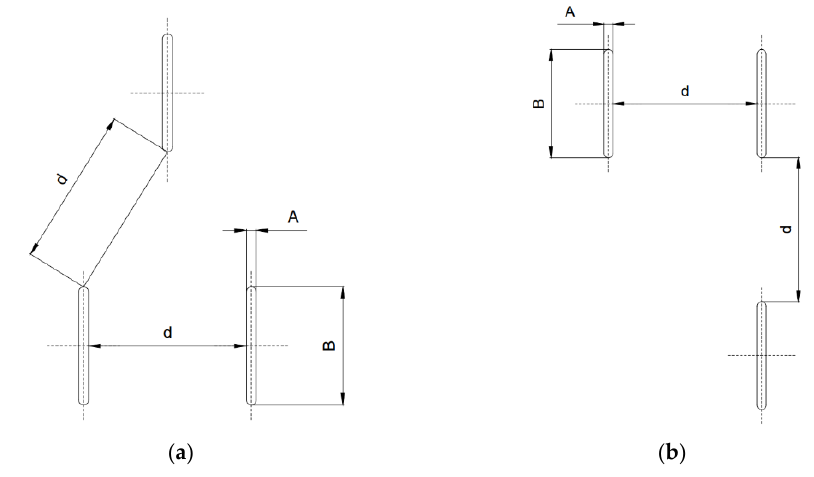
Figure 2. Layout of: ( a ) Model 1; ( b ) Model 2.